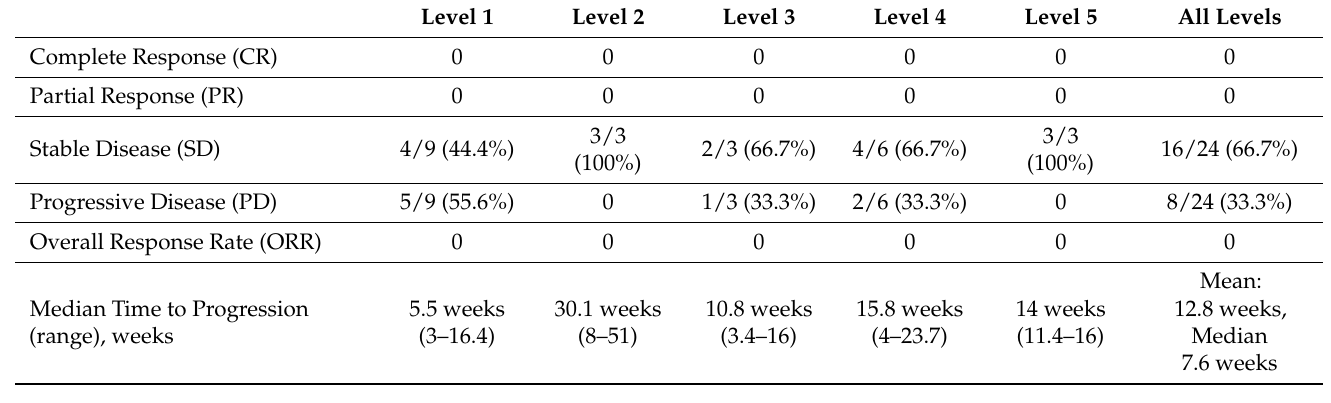
Table 4. RECIST responses by dose level.